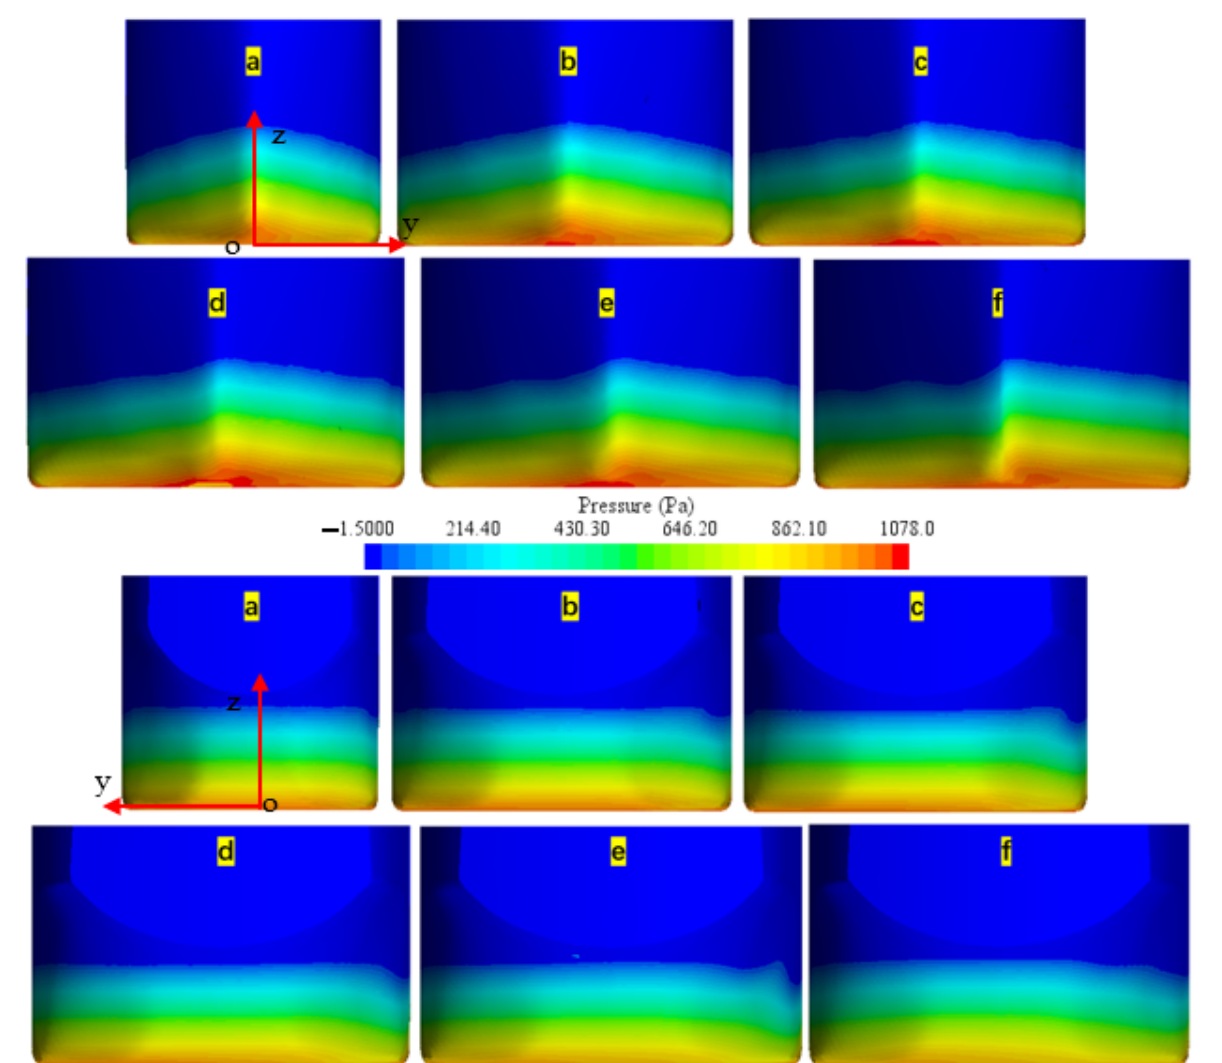
Figure 17. Pressure distribution at bow and stern for ship type variation. ( a – f ): L pp = 1.54 m, 2.68 m, 3.6 m, 4.4 m, 5.4 m, 7.2 m; corresponding beam = 0.202 m, 0.328 m, 0.38 m, 0.45 m, 0.45 m, 0.45 m.